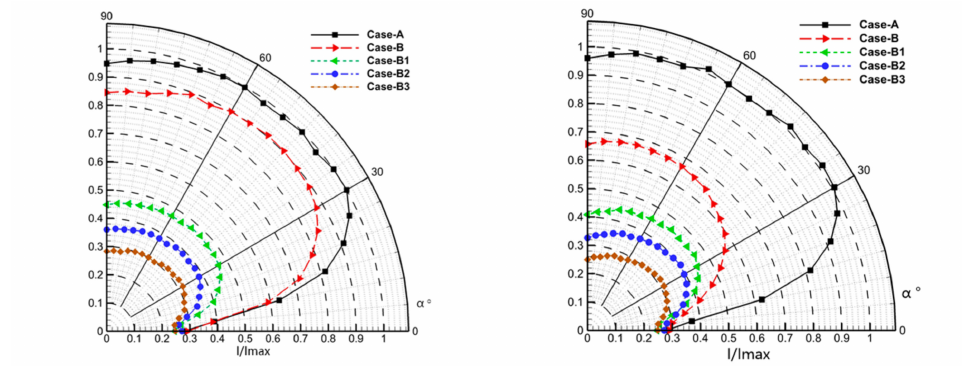
Figure 13. Dimensionless radiation